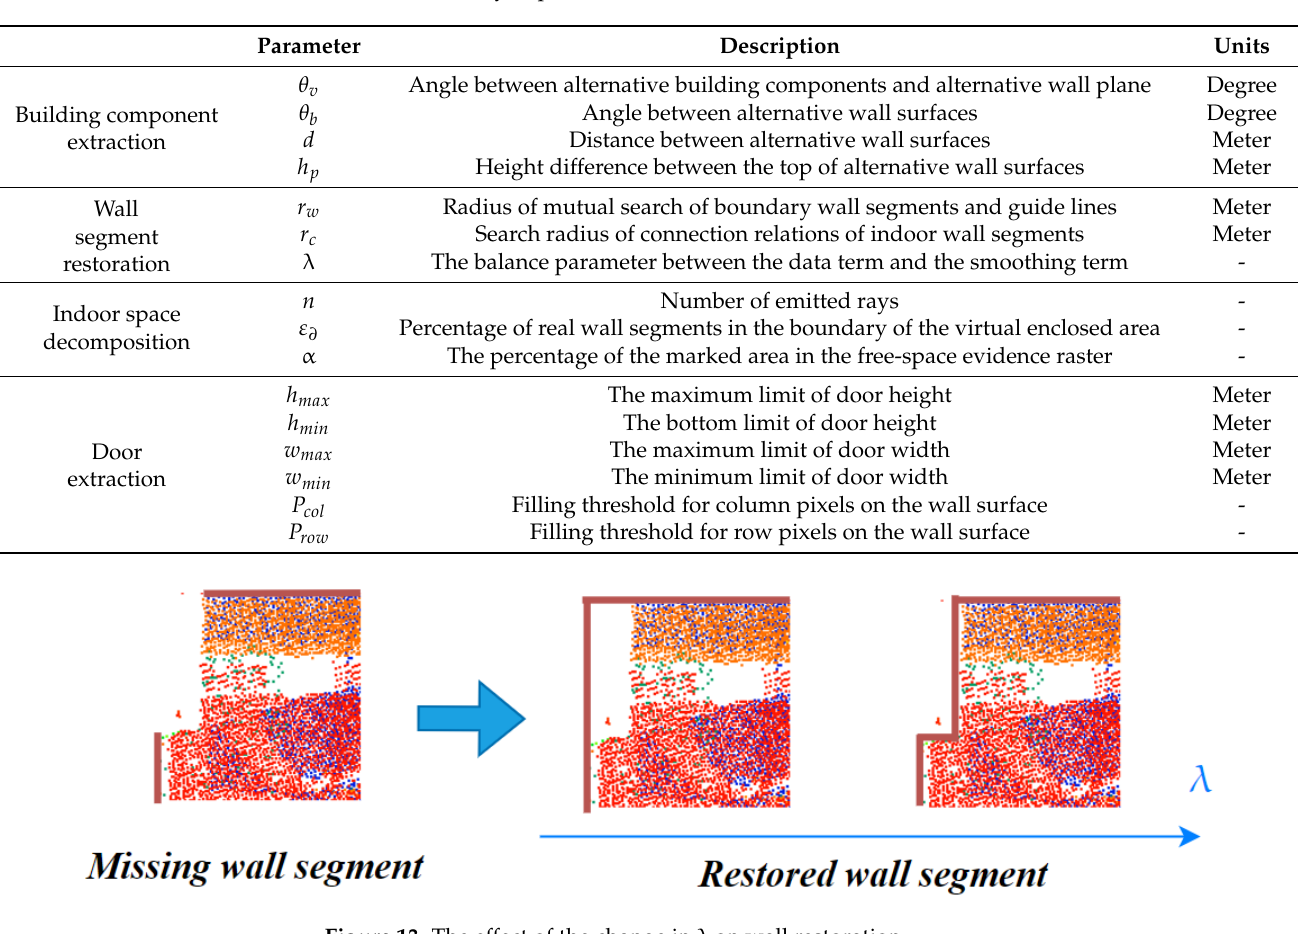
Table 1. Summary of parameters for model extraction and reconstruction.